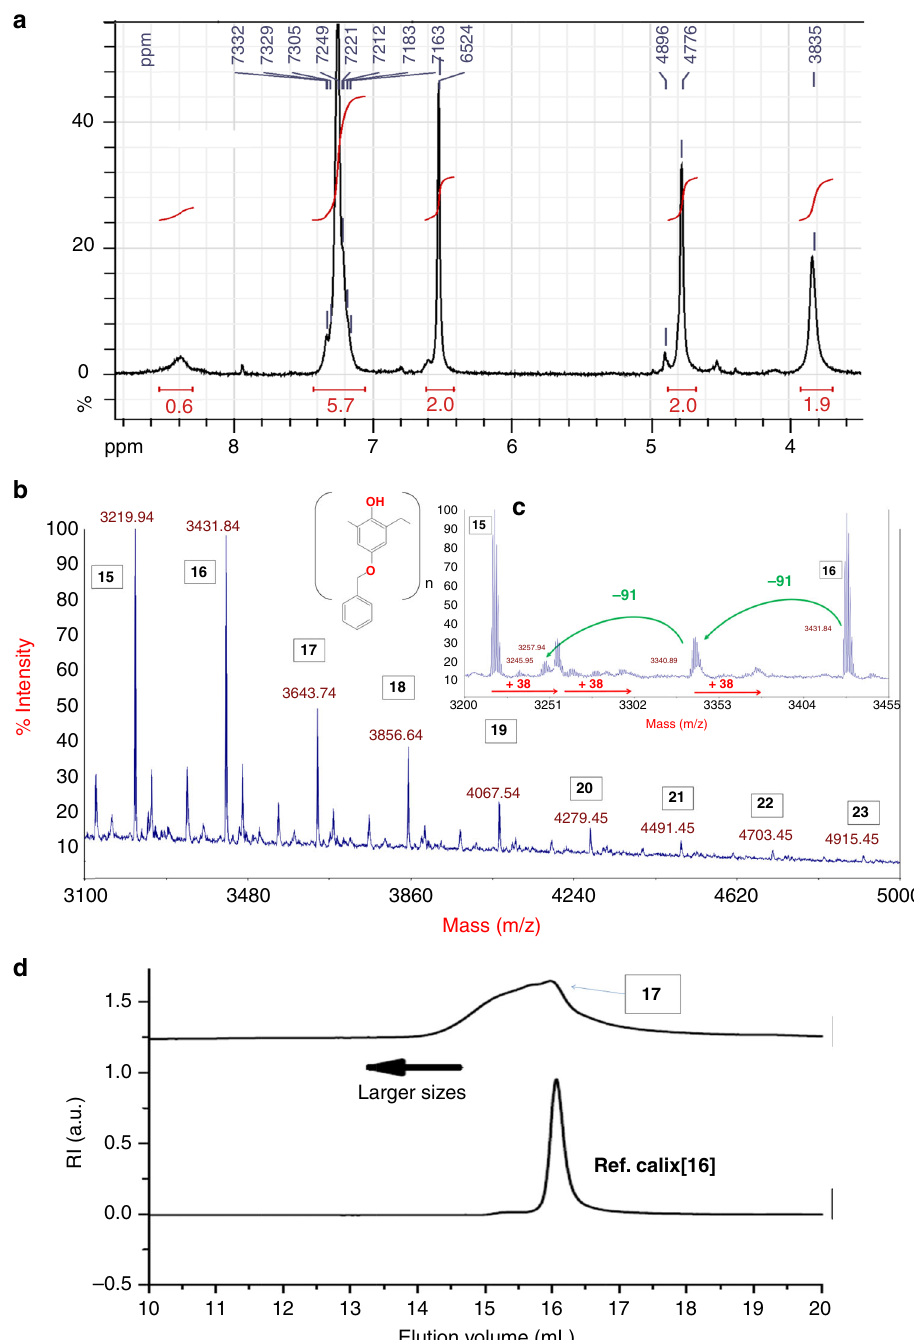
Fig. 4 Analysis of a giant calixarenes synthesis (two-steps process, 0.4 equivalent of CsOH vs phenol). a 1 H NMR (DMSO-d6); b re fl ectron-mode MALDI- TOF MS (K + cationized); c zoom over the MALDI-TOF MS spectrum (photoinduced debenzylations and hydrogen/metal exchanges shown as green and red arrows, respectively); d compared SEC analyses of puri fi ed giant calixarenes with a reference sample of pure p -(benzyloxy)calix[16]arene. PRU numbers shown in the